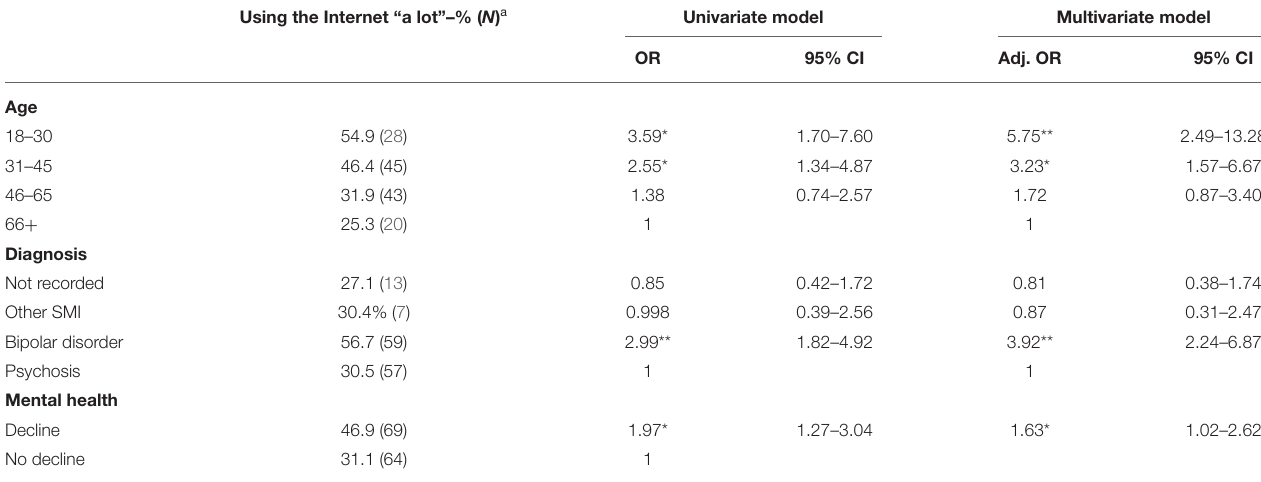
TABLE 5 | Post-hoc exploratory analysis: association of mental health decline with Internet use, adjusting for age, and diagnosis. Using the Internet “a lot”–% ( N )